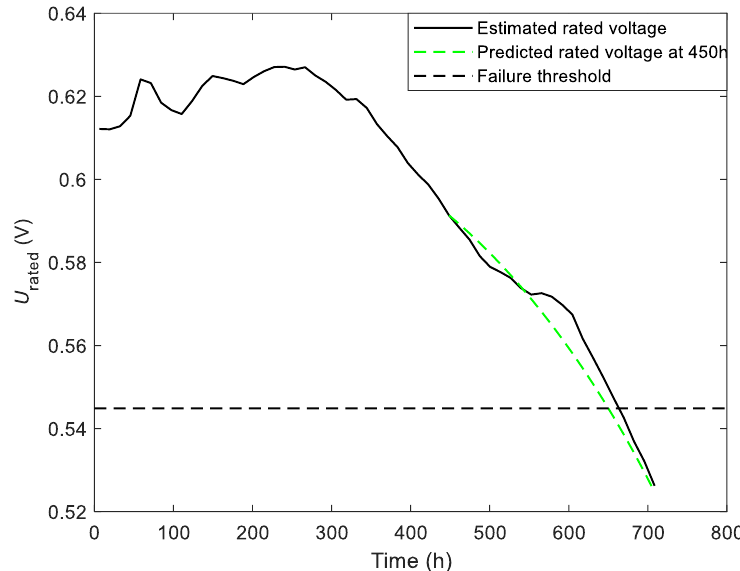
Figure 9. The degradation trend predicted at different time.